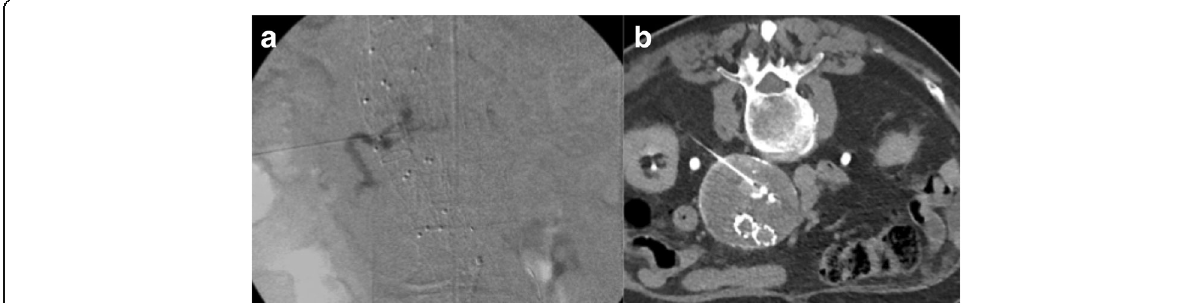
Fig. 5 a Direct puncture of the sac under CT and fluoroscopic guidance. Angiogram confirms the presence of the small nidus and the feeding vessel. b CT scan during embolisation with